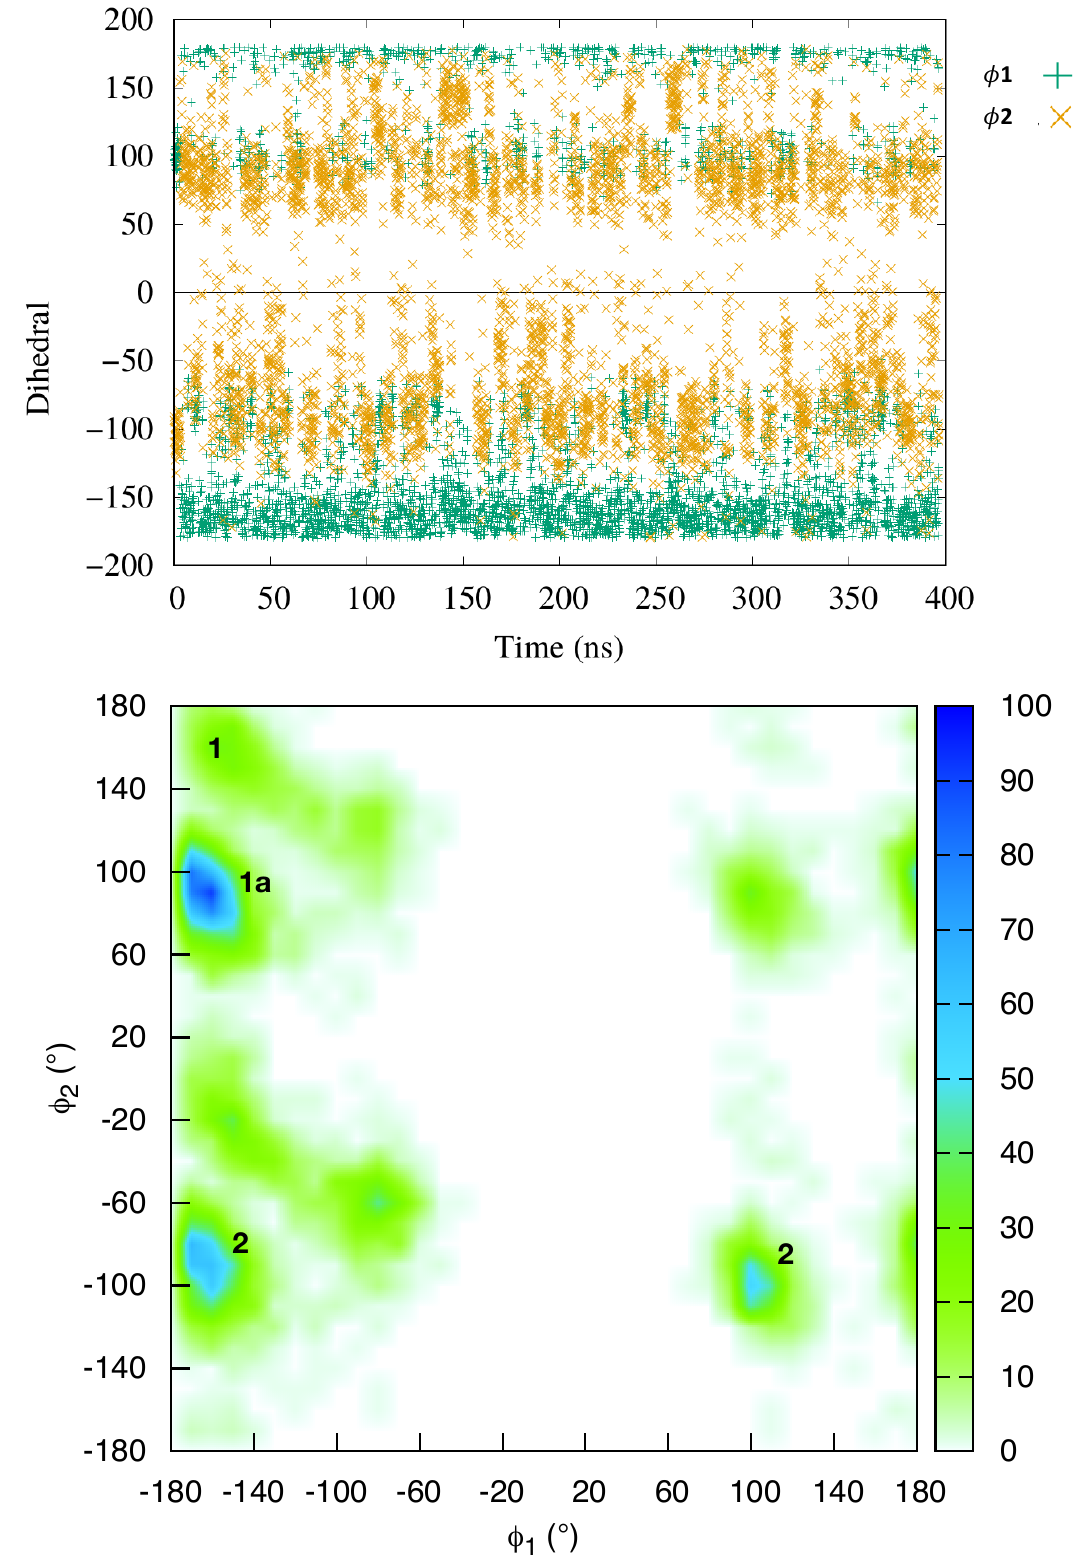
Figure 1. (Top) Time series of the representative dihedral angles φ 1 (in green) and φ 2 (in yellow) over the equilibrium MD trajectories. (Bottom) Distribution of the φ 1 and φ 2 dihedral angles over the trajectory.